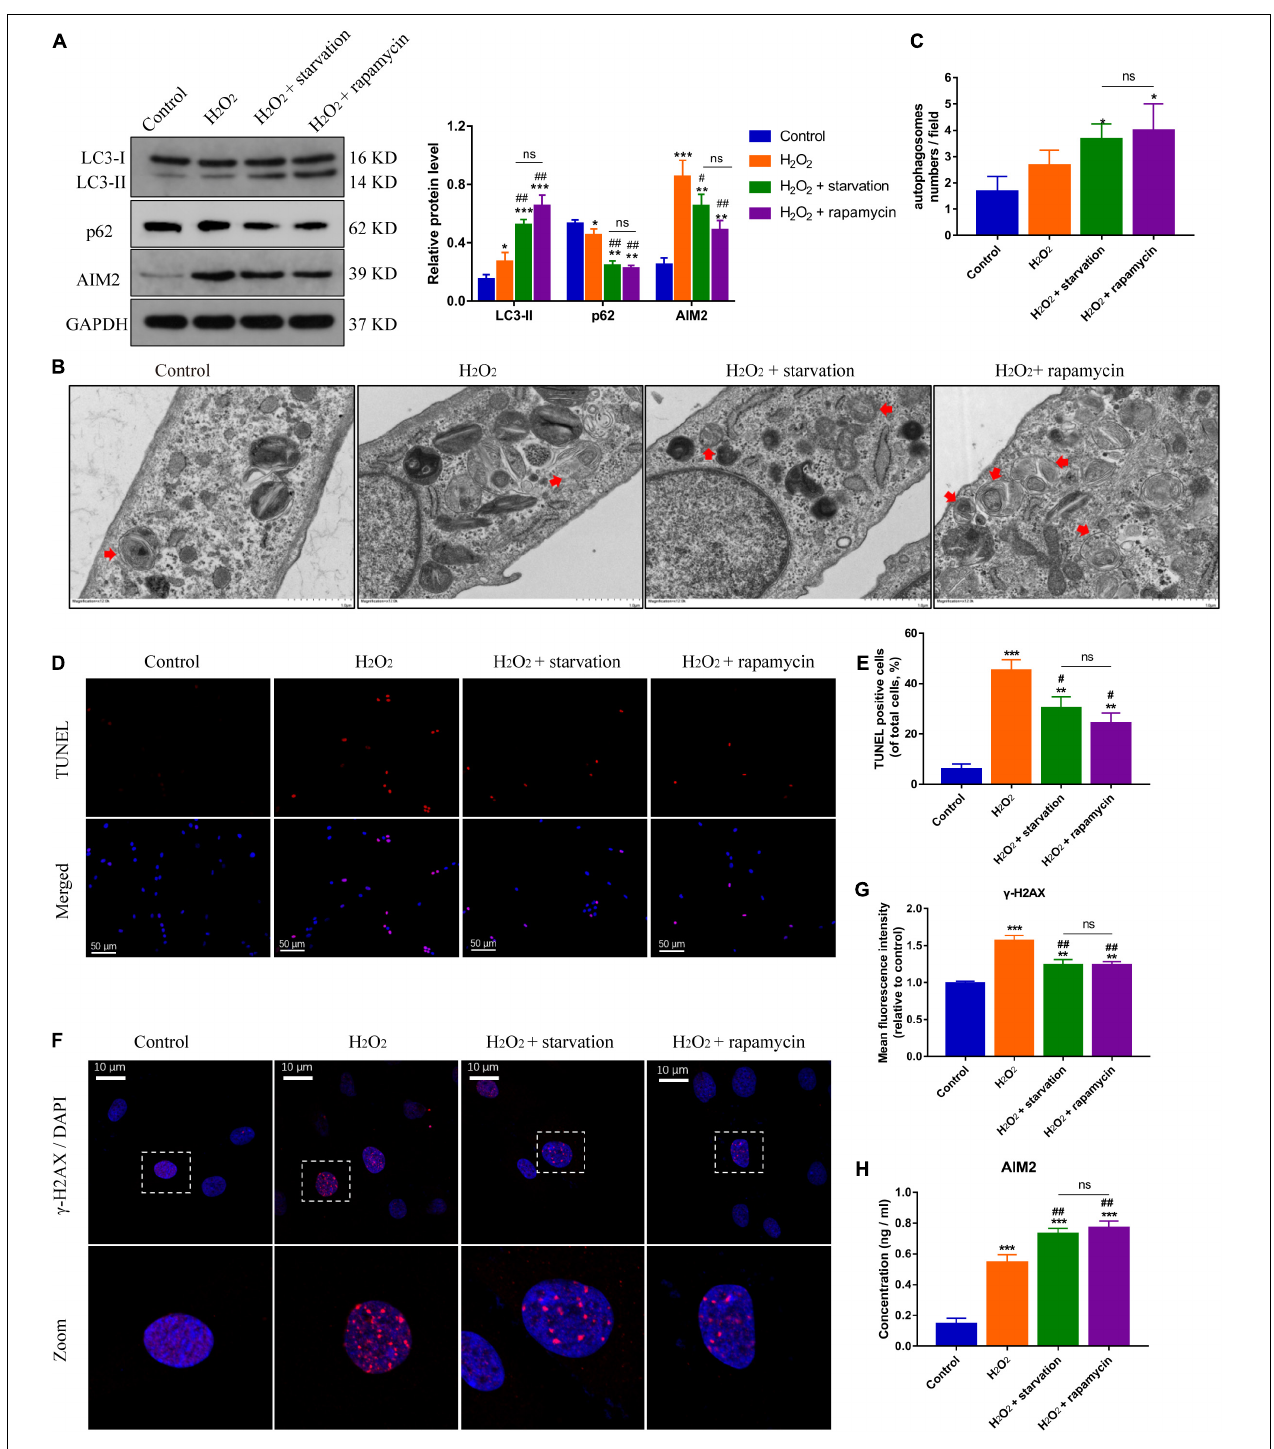
FIGURE 3 | Induction of autophagy reduces DNA damage and NP cell apoptosis, and facilitates AIM2 secretion. (A) Protein levels and quantification of AIM2, LC3 and p62 in H 2 O 2 -treated NP cells pre-treated with starvation (8 h) or rapamycin (10 µ M, 8 h). (B,C) TEM images of NP cells indicated the number and morphology of autophagosomes (red arrows), and quantification of autophagosomes numbers (C) . (D,E) TUNEL images of NP cells in different groups (D) and corresponding quantification of cell apoptosis (E) . (F,G) Immunostaining of γ -H2AX (F) and mean fluorescence intensity of NP cells in different groups (G) . (H) Secretion of AIM2 measured by ELISA analysis. Data were presented as the means ± SD, n = 3. * P < 0.05, ** P < 0.01, *** P < 0.001 vs. control group; # P < 0.05, ## P < 0.01 vs. H 2 O 2 group; ns, P > 0.05, no significant